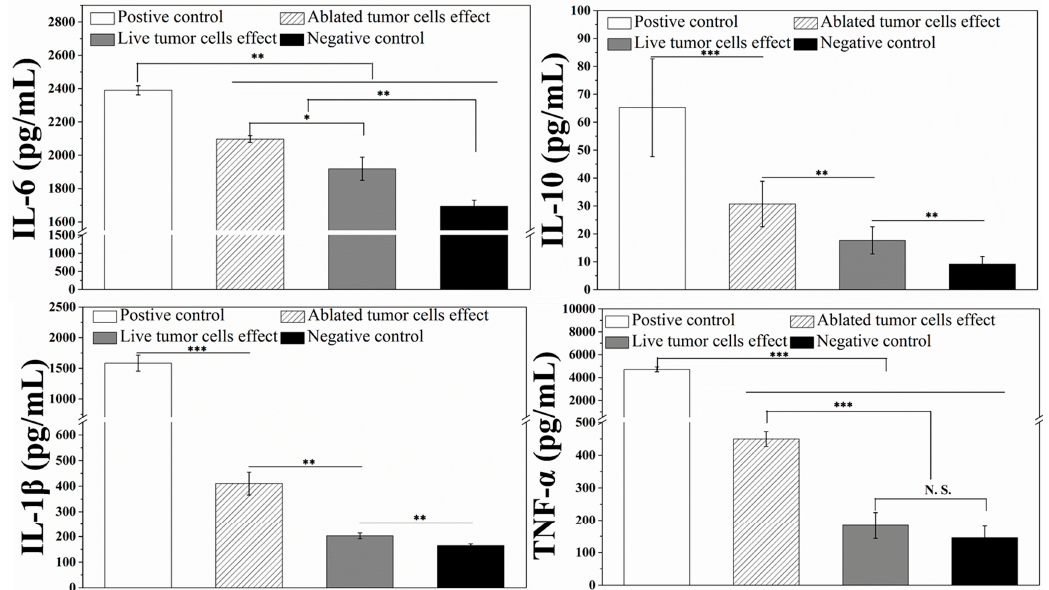
Figure 5. Secretion level of IL-6, IL-10, IL-1 β and TNF- α by dendritic cells (DCs) after being co-cultured with living 4T1-Luc cells and photothermally ablated 4T1-Luc cells in the AuNRs-gelatin composite porous scaffold. Positive and negative controls are DCs cultured in the composite scaffolds with and without LPS, respectively. The data represent the means ± S.D. (n = 3). No significant difference: N.S.; significant difference: * p < 0.05; ** p < 0.01; *** p < 0.001.